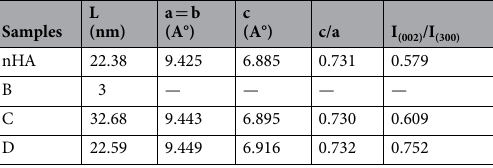
Table 1. Crystallite size (L) and crystallographic parameters of nHA crystallites dispersed in Dex-CS/nHA composite